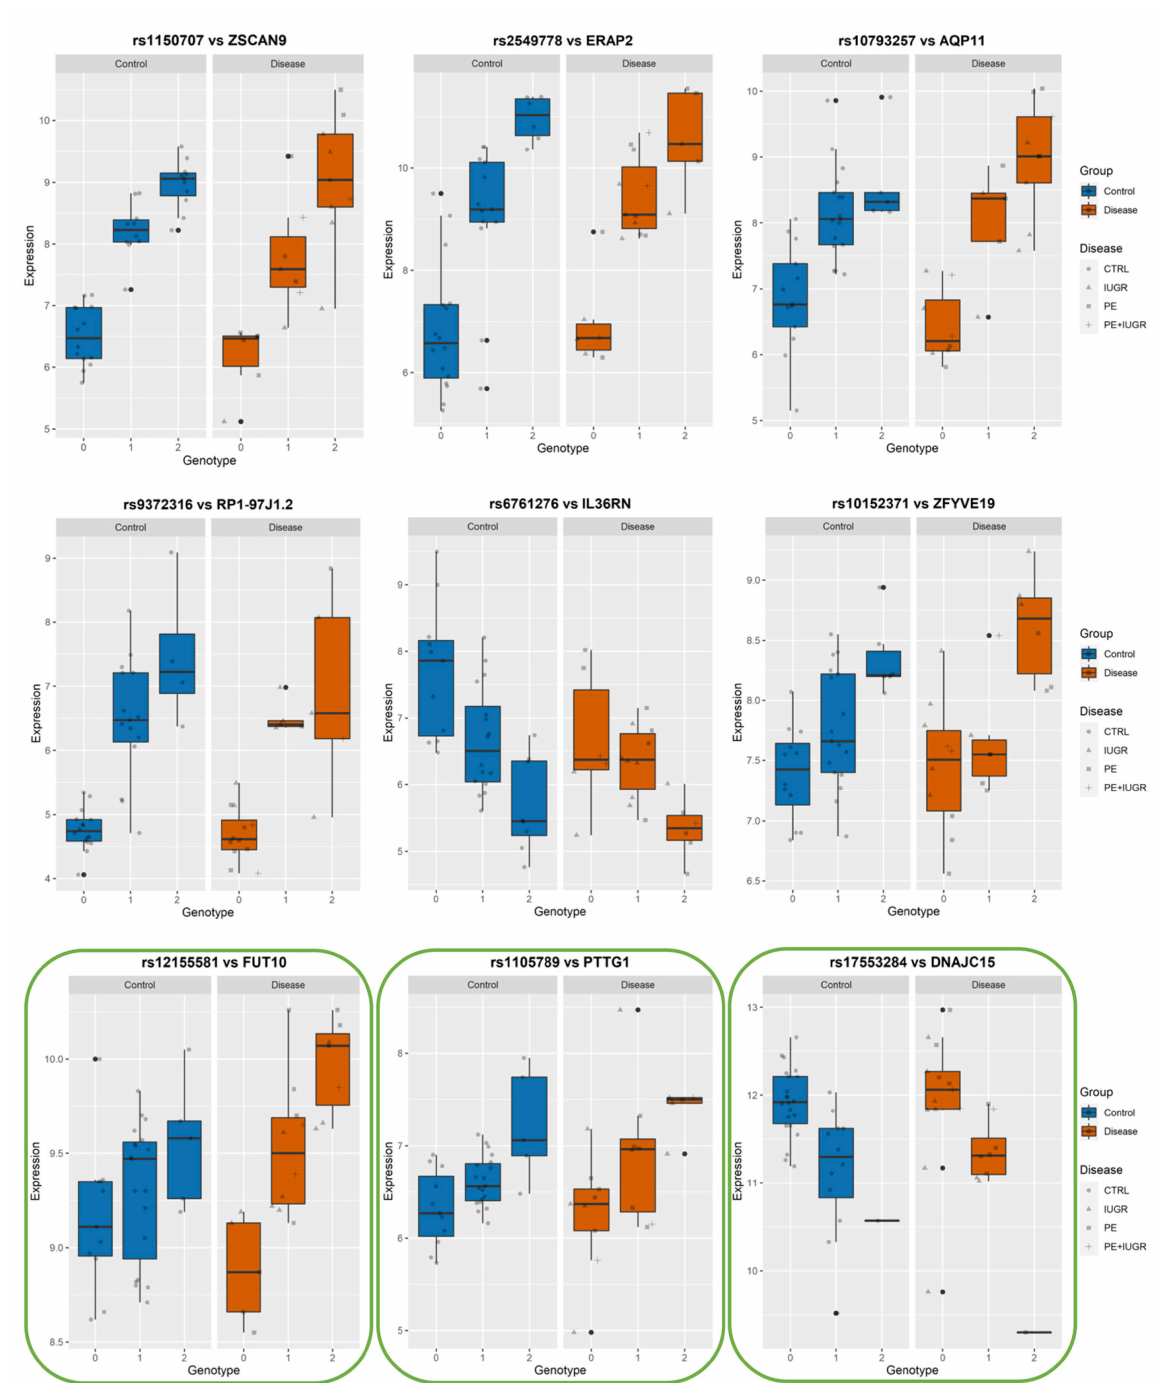
Figure 6. Boxplots of eGene expression in relation to the best-eSNP genotype, stratified by Group: Control vs. Disease. eGenes ZSCAN9, ERAP2, AQP11, RP1-97J1.2, IL36RN, ZFYVE19, FUT10, PTTG1, DNAJC15.The genotype of each SNP is expressed as 0, 1, 2, and the gene expression data corresponds to the raw data as mean fluorescence value. CTRL = Control; IUGR = Intra-uterine Growth Restriction; PE = Preeclampsia. Genes discussed in the text, because of their relevance to placental biology, are highlighted in